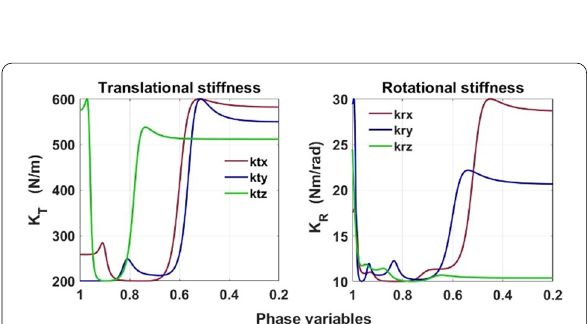
Figure 6 Variable stiffness obtained from